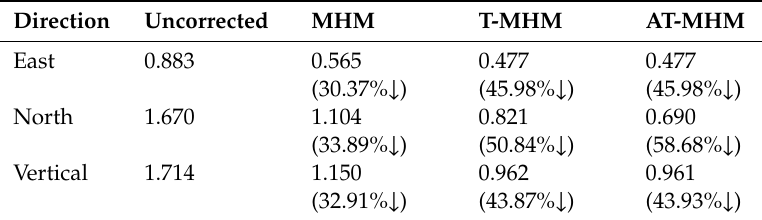
Table 5. The root mean square error (RMSE) comparison between solutions of MHM, T-MHM, and AT-MHM on DOY 50. (Unit: meter). Direction Uncorrected MHM